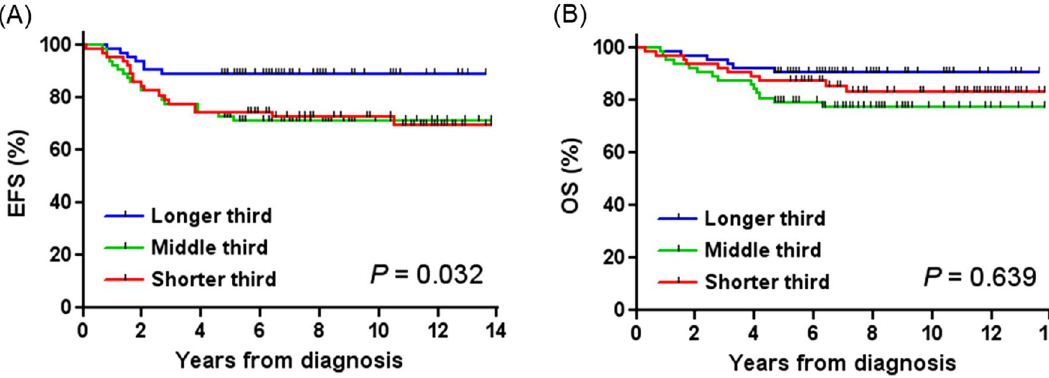
Figure 1. Survival data according to germline telomere length. ( A ) Patients with longer third telomeres showed longer event-free survival than other patients, ( B ) but there was no statistical difference in overall survival.